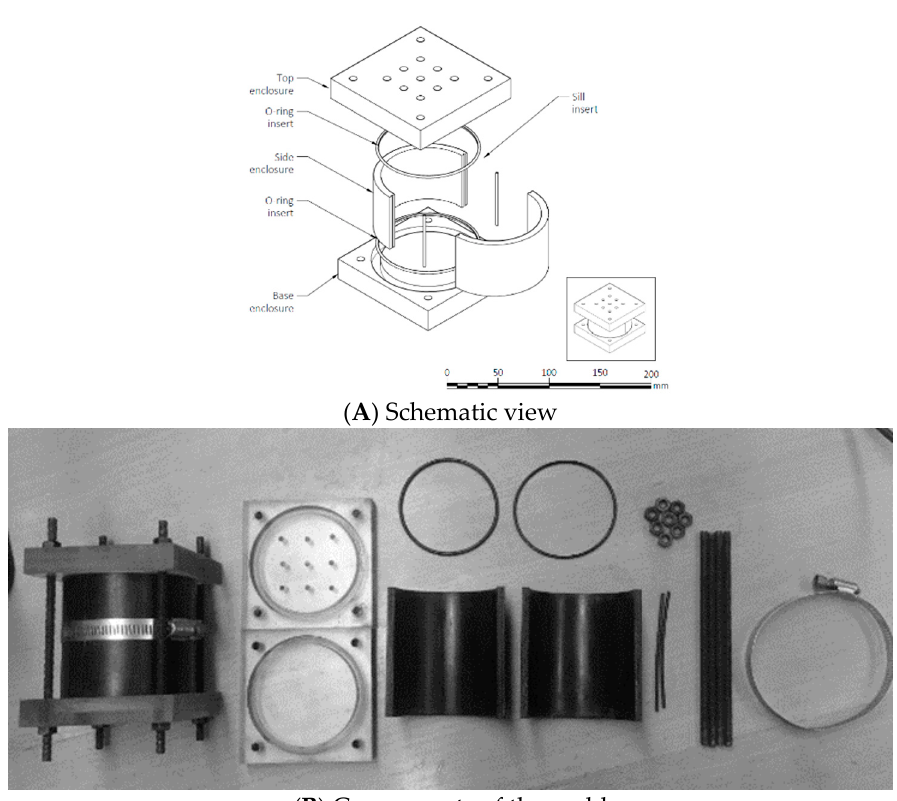
Figure 2. Punching shear sample mold.